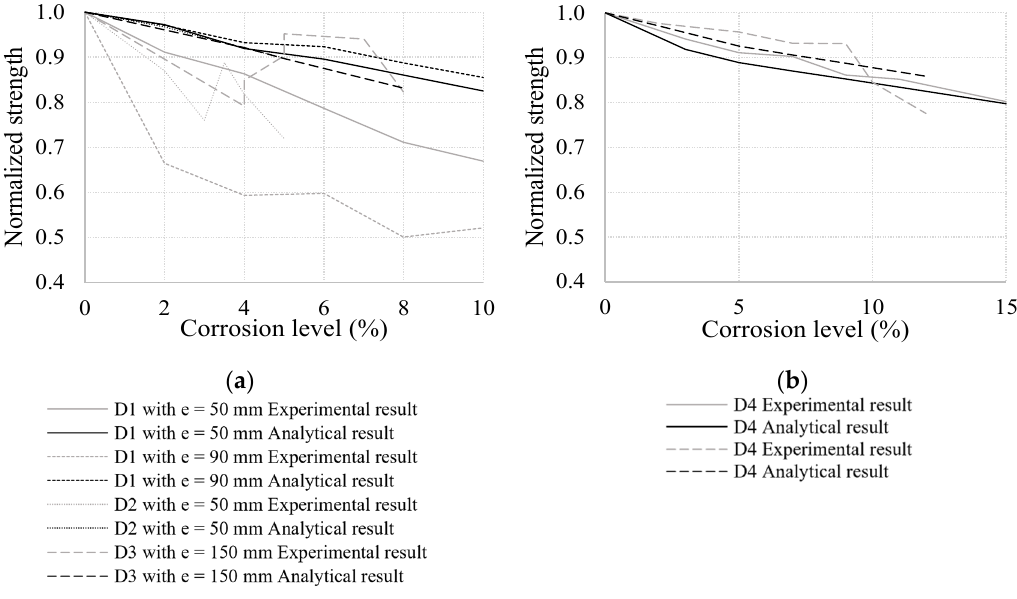
Figure 9. The validation of strength degradation: ( a ) Flexo-compressive strength; ( b ) bending